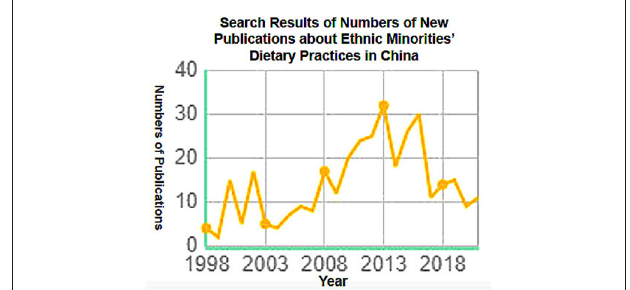
FIGURE 2 | The distribution of publications of dietary practices among ethnic minority groups in China from 1998 to 2021 (generated by Wanfang Med